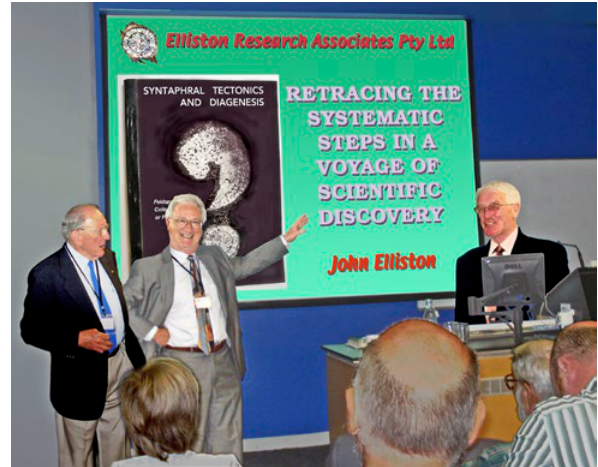
Figure 17. John Elliston (left), Professor Ross Large, Director of CODES, and Professor T. W. Healy, Particulate Fluids Processing Centre, University of Melbourne (right), at the symposium on sedi- ment mobility and ore genesis at CODES in Hobart, November